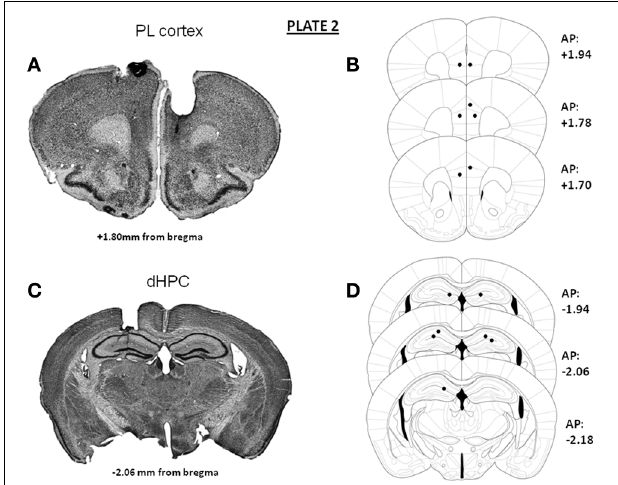
Plate 2 | Representative photomicrographs and antero-posterior extent of the unilateral implantations of cannulae into the prelimbic cortex (A,B) and the dorsal hippocampus (C,D) in the same animal for the microdialysis study. On the right of each diagram, stereotaxic anterio-posterior (AP) coordinates are mentioned (in mm from